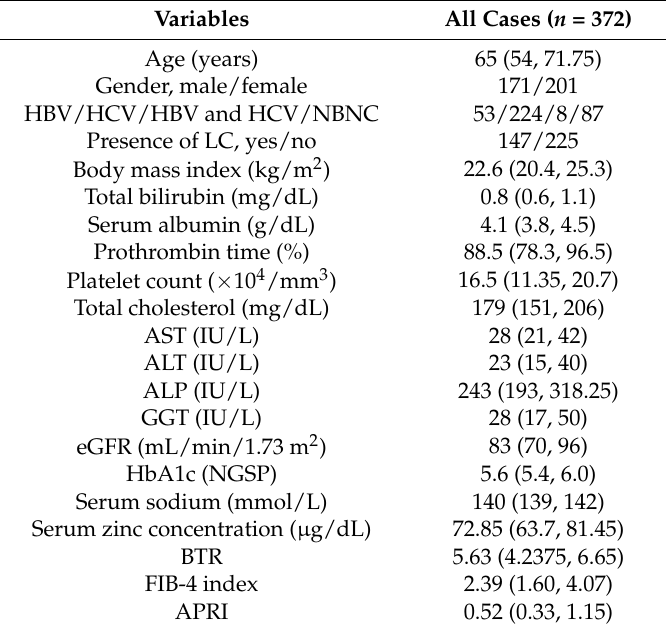
Table 1. Baseline